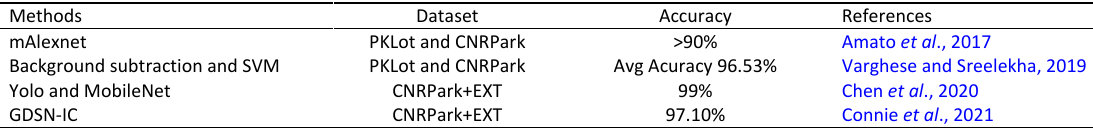
Table 1: The Summary of vision-based methods for parking space classification